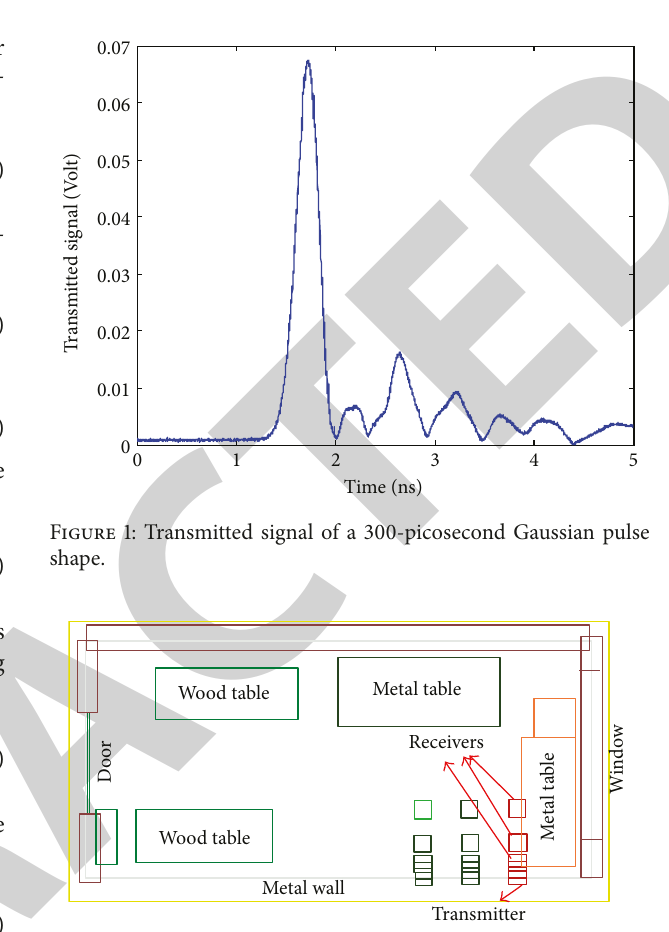
Figure 2: The indoor environment considered in our experiment.